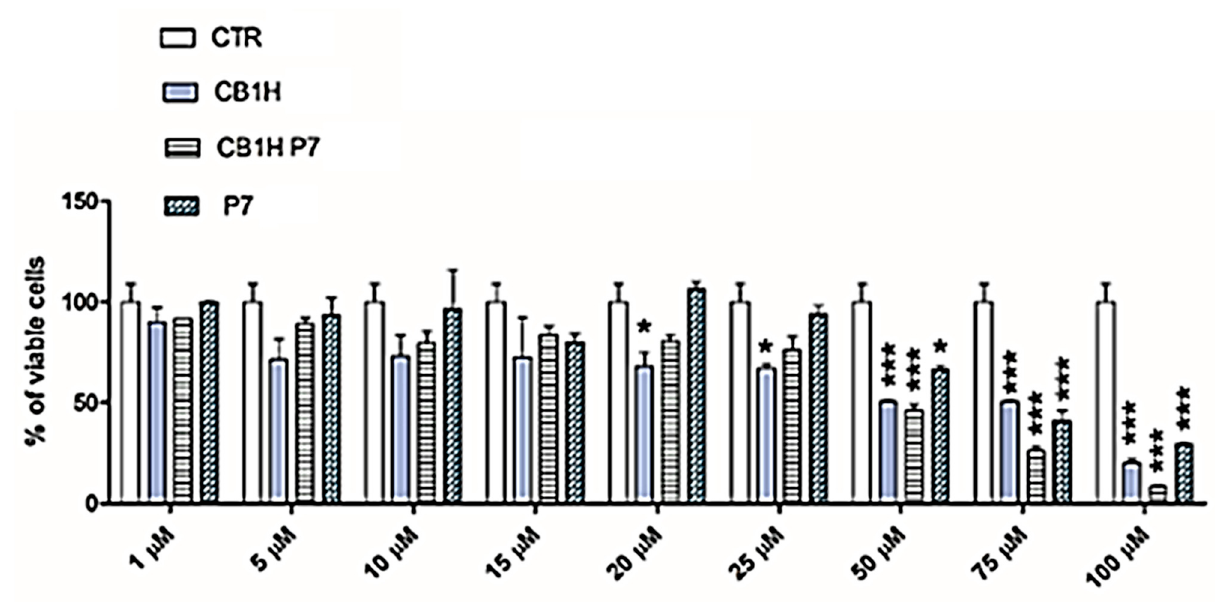
Figure 4. Dose-dependent cytotoxicity activity of P7, CB1H and CB1H-P7 NPs at 24 h towards HaCaT cells. The statistical significance of differences between experimental and control groups was determined via a two-way analysis of variance (ANOVA) with the Bonferroni correction. Asterisks indicate the following p -value ranges: * = p < 0.05, *** = p < 0.001.